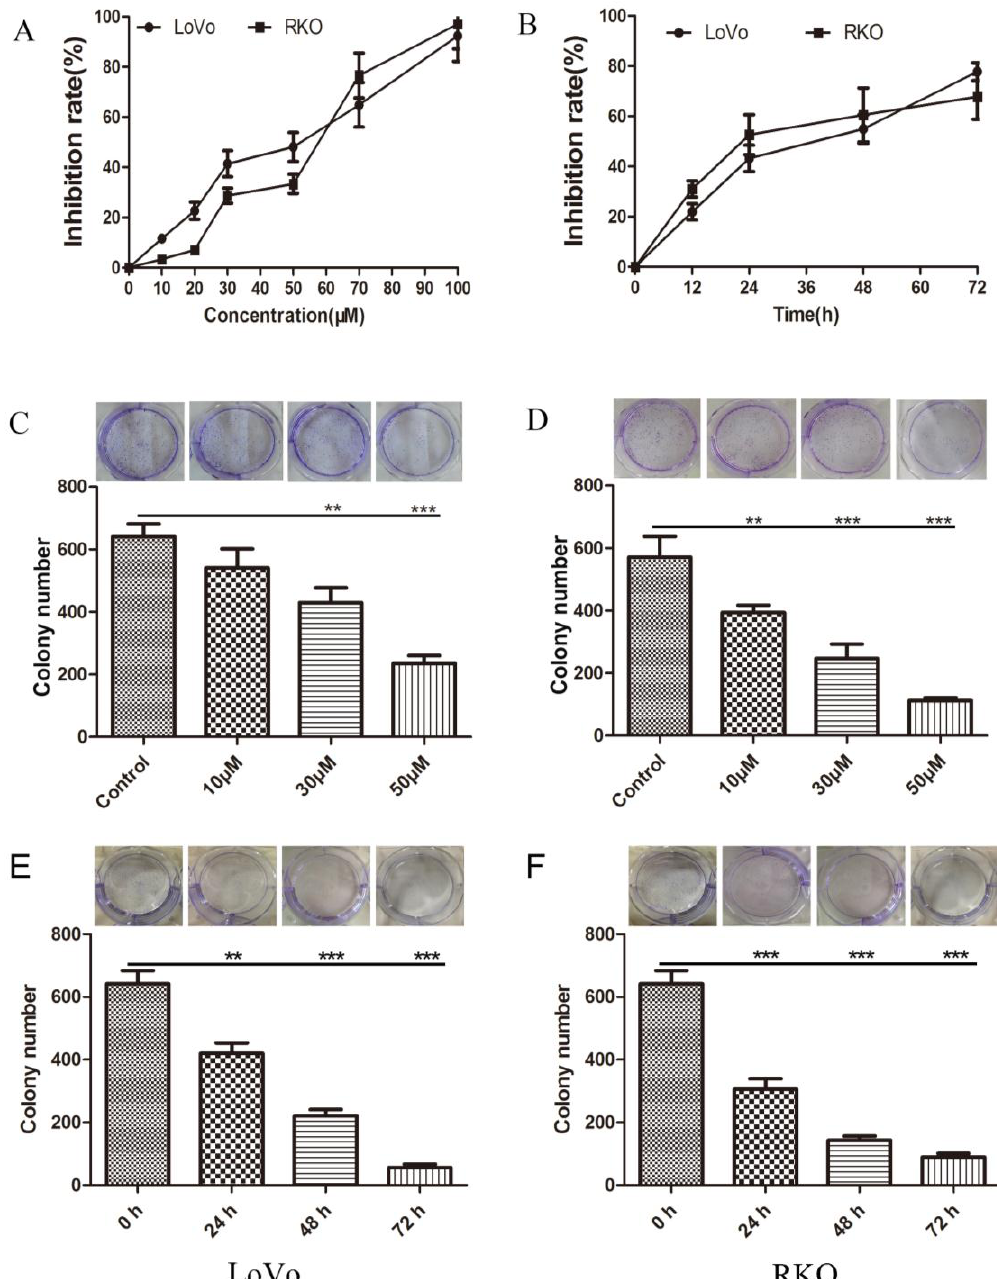
Figure 1. Methyl Sartortuoate induced cell proliferation inhibition in coloron cancer LoVo and RKO cells. ( A ) Cell inhibition rate was measured with MTT when LoVo and RKO cells were treated with Methyl Sartortuoate at indicated concentrations for 24 h; ( B ) LoVo and RKO cells were treated with Methyl Sartortuoate at 50 M for different time intervals; ( C , D ) LoVo and RKO cell colony formation with or without Methyl Sartortuoate treatment. Results are presented as the average of quadruplicate measurements, and the bar is the standard deviation ( n = 3). ** p < 0.01 and *** p < 0.001 versus control group; ( E , F ) LoVo and RKO cells colony formation with Methyl Sartortuoate treatment at 30 µM for 24, 48 and 72 h. Results are presented as the average of quadruplicate measurements, and the bar is the standard deviation ( n = 3). ** p < 0.01 and *** p < 0.001 versus 0 h